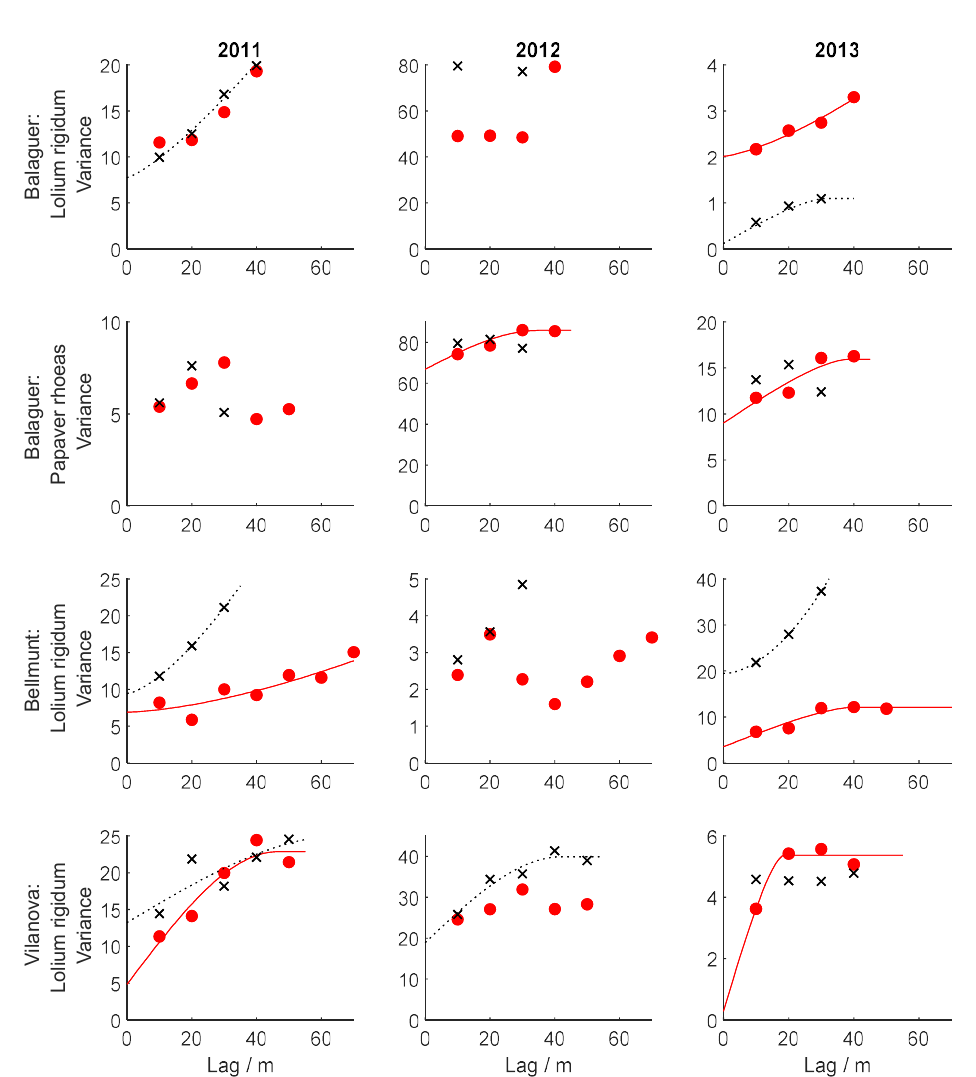
Figure 5. Empirical variograms with fitted models (solid and dotted lines) for harrow-tilled sites. Variograms with lag distance in the direction of traffic are shown by the red discs, and those with lag distance perpendicular to traffic are shown by the black crosses. The model parameters are given in Table 4. Where no line appears, a model could not be fitted.